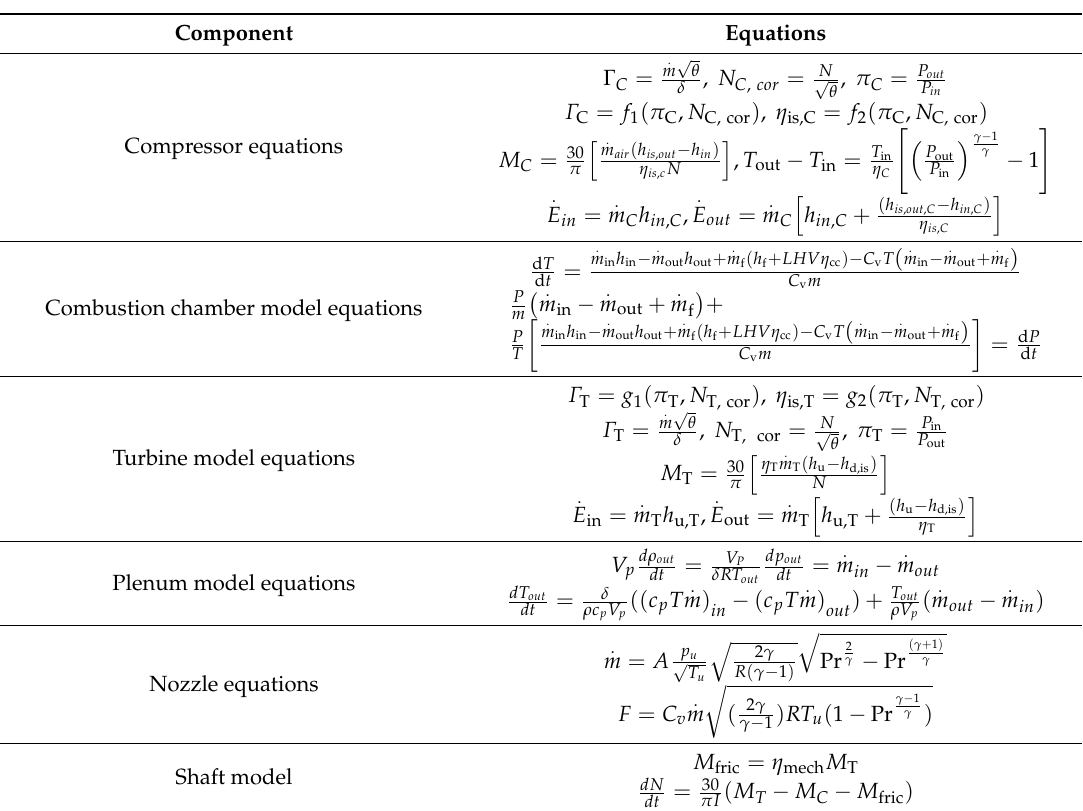
Table 3. Equations used to generate the bond graph model for the jet